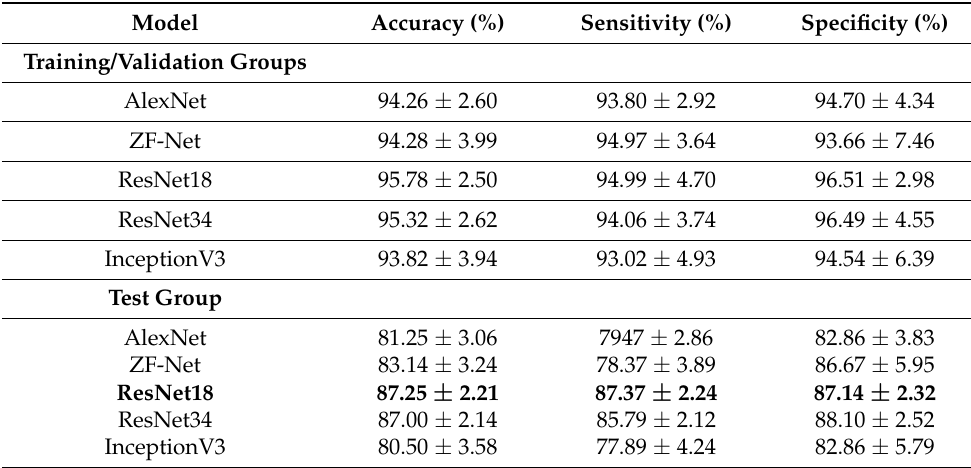
Table 2. Classification performance in NC vs.